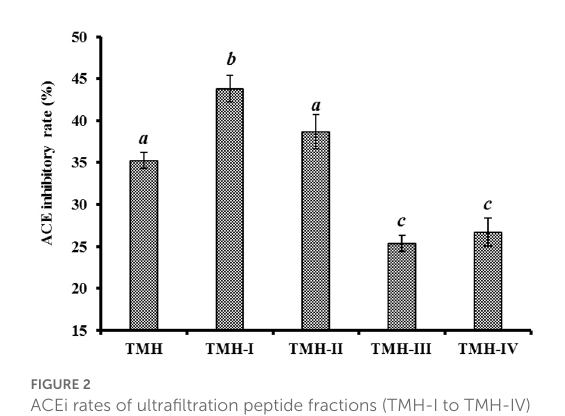
FIGURE2 ACEi rates of ultrafiltration peptide fractions (TMH-I to TMH-IV) of protein hydrolysates (TMH) of skipjack tuna milts at a concentration of 1.0 mg/mL. a − c Values with same letters indicated no significant difference ( P > 0.05).